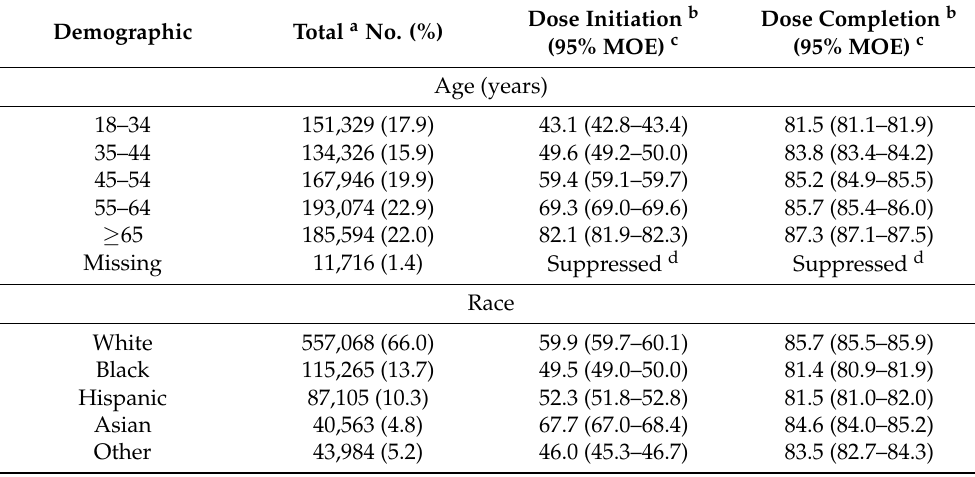
Table 1. COVID-19 Vaccination Initiation and Completion Rates by